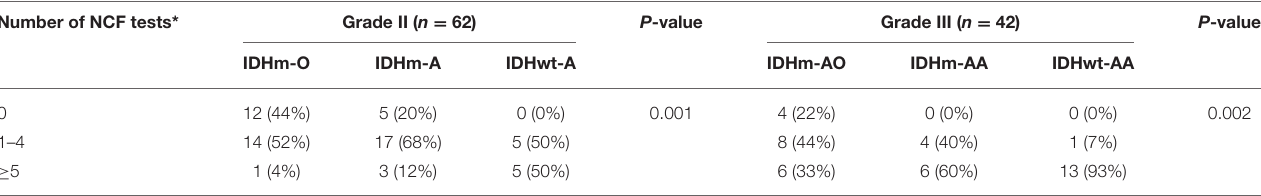
TABLE 7 | The proportion of NCF decline in molecular